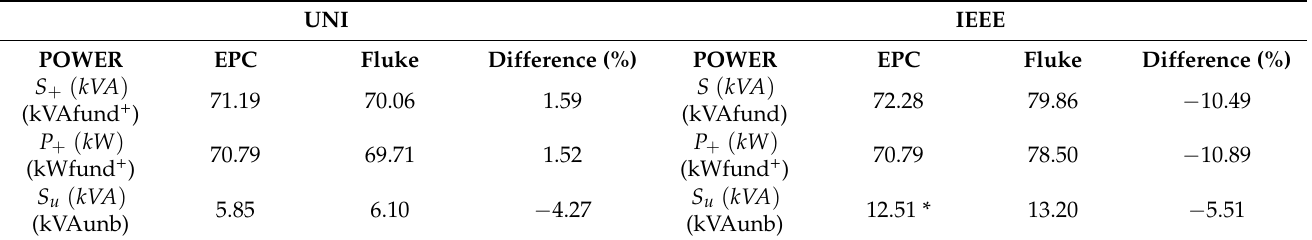
(cid:113) − S 2 S 2 + IEEE